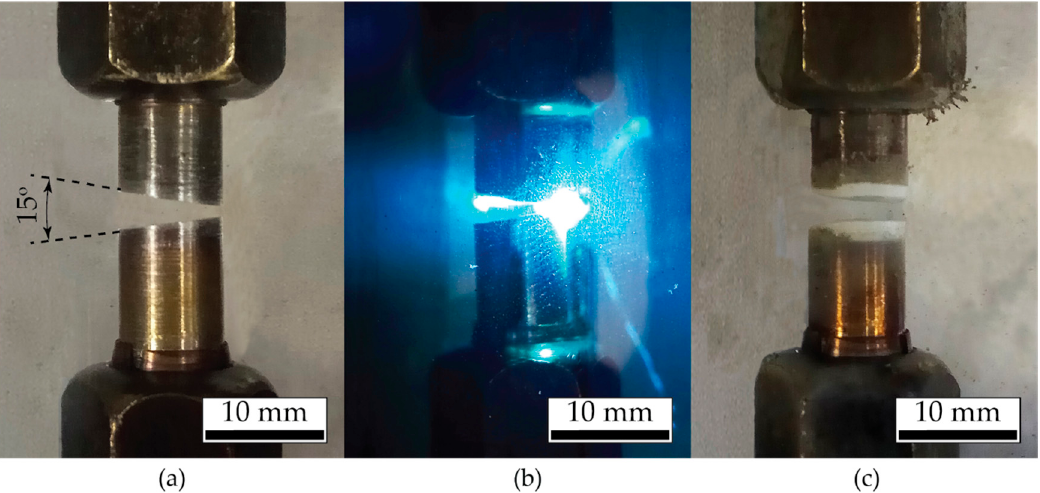
Figure 3. Photos of the gap between the electrodes with end faces forming the angle of 15°: ( a ) before the start of the SD process, ( b ) during the discharge process and ( c ) 6 h after the spark treatment by the ODP.